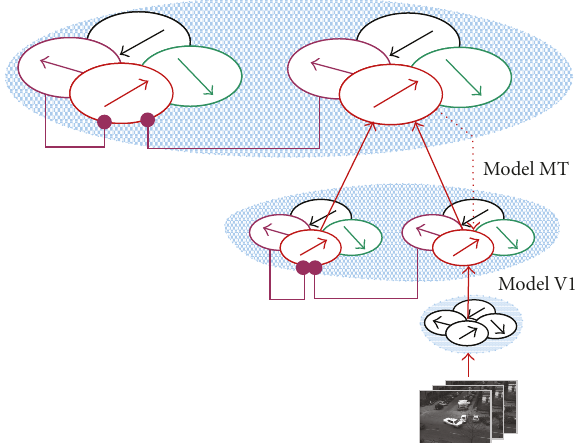
Figure 4: Schematic view of the model showing the interactions of the di ff erent cortical stages that were taken into account by the model. In essence, it is shown how initial motion is detected and further processed at the stage of area V1. V1 activity is fed forward (red lines with arrow heads) to be integrated by motion selective cells in model area MT. Such cells integrate over a larger spatial neighbourhood and thus build an increasing spatial scale. Cells in V1 as well as in MT interact via inhibitory connections (purple lines with round heads). Feedback from MT to V1 (red dashed lines with arrow heads) connects cells of corresponding selectivity in the motion feature